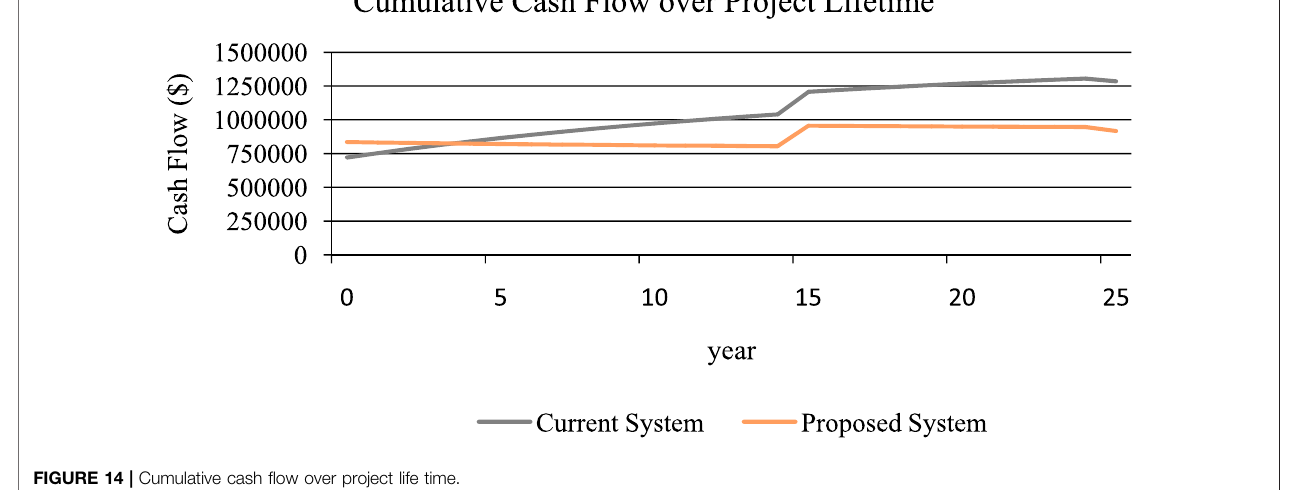
FIGURE 14 | Cumulative cash fl ow over project life time.